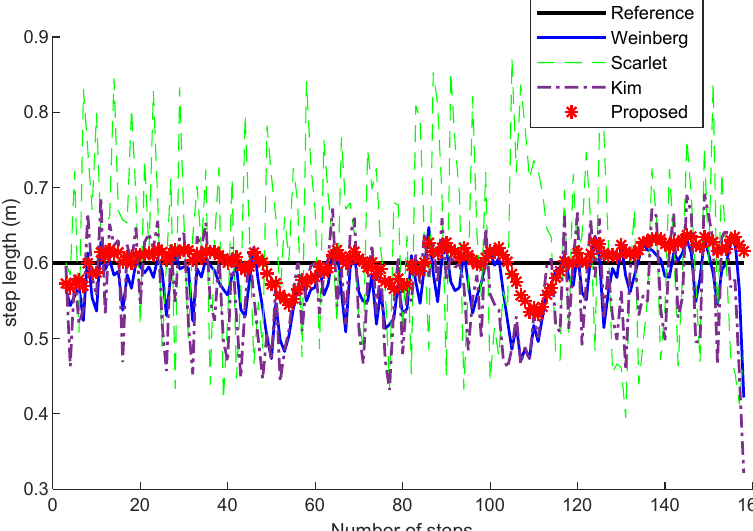
Figure 6. Comparisons of step length estimation at different step numbers with Scarlet, Kim, Weinberg and the proposed method.